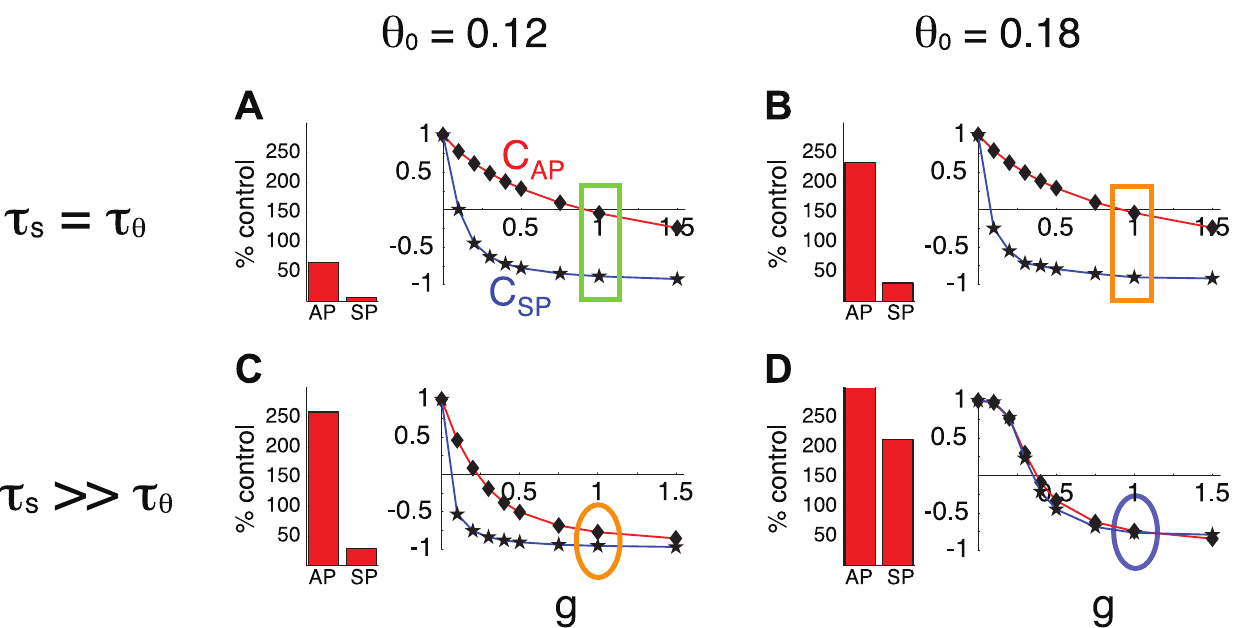
Figure 7. The blockade experiment does not inform on the relative contributions of each process to rhythmic activity. Panels A, B, C, D correspond to cases shown in panels v, vi, viii, ix in Figure 2. For each case, the change in AP and SP durations following h block is shown next to the variations of C AP (red, diamonds) and C SP (blue, stars) with g (the maximum amplitude of cellular adaptation). Blocking h means changing g from 1 to 0. As g reaches 0, both C AP and C SP reach 1 since s becomes the only variable controlling episodic activity. In A and B, the contributions measures are also the same before the block (g=1, rectangle highlights), nevertheless the blockade leads to different changes in AP and SP durations. Thus, these changes in durations after the block cannot be used to predict the respective contributions of each process before the block. Panels C and D illustrate the same points, with similar contributions measures before the block (oval highlights) but different effects of the block on AP and SP durations. Finally, panels B and C show that despite different contributions measures (oval vs. rectangle highlight) before the block, the resulting effect of the block on AP and SP durations are the same. Again, results from the block do not provide much information about the respective contributions of each process before the